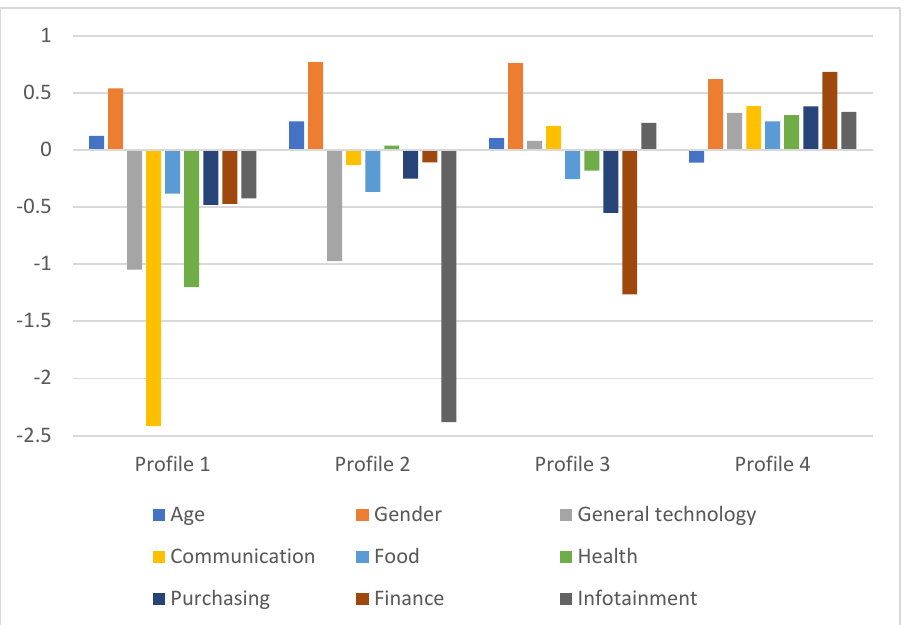
Figure 1. Characteristics of extracted profiles. The figure contains absolute values for gender and standardized ( Z ) values for other variables.